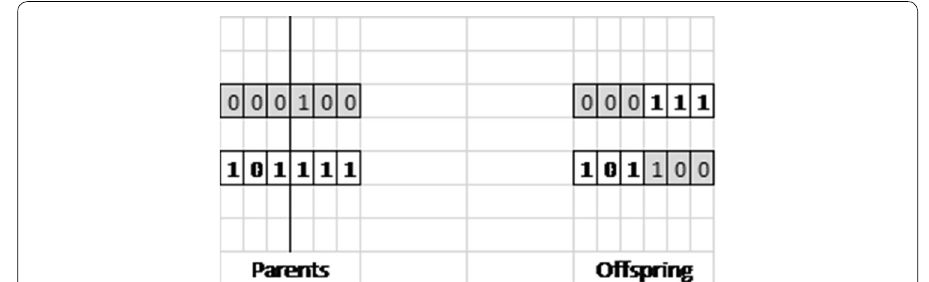
Fig. 1 Illustration of one-point crossover